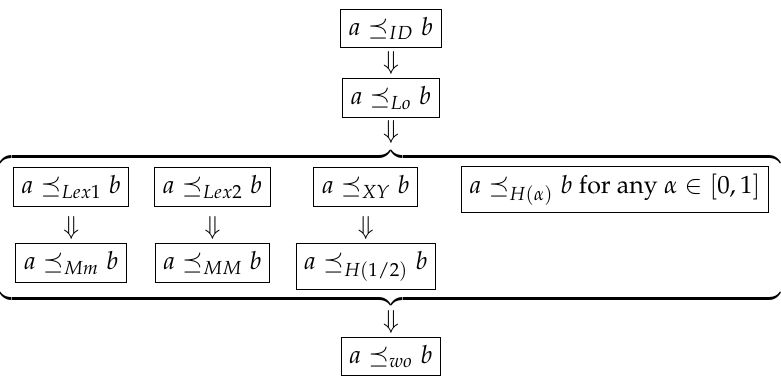
Figure 2. Relationships among the different relations.